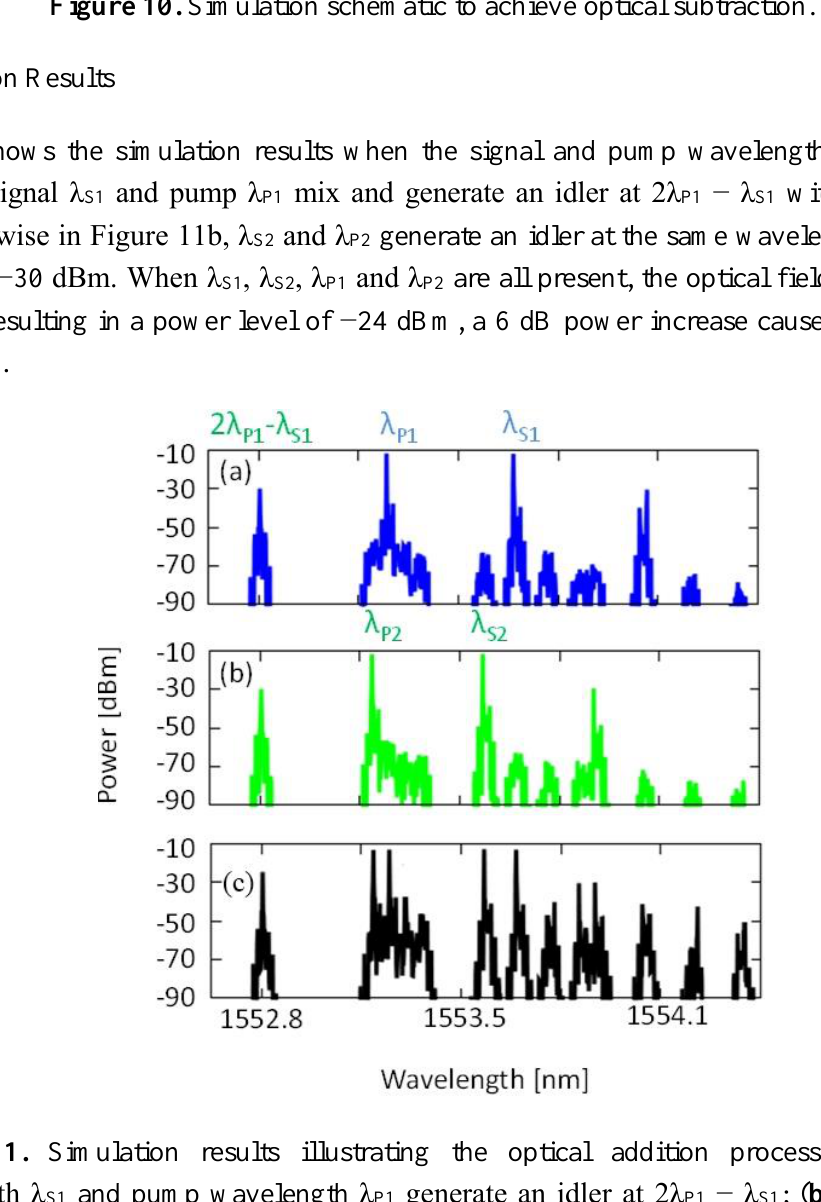
Figure 10. Simulation schematic to achieve optical subtraction.